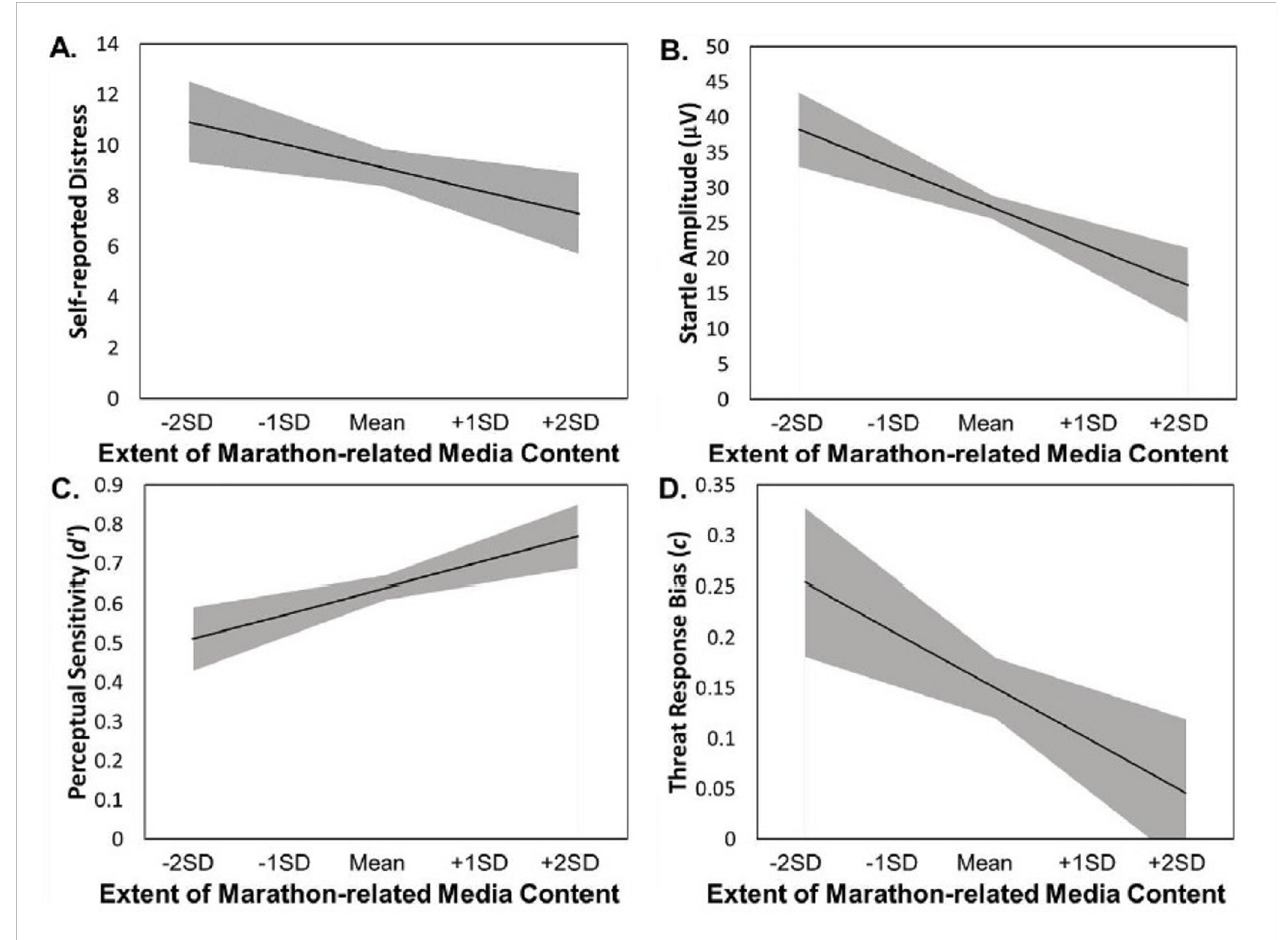
Fig 2. Simple slopes representation of models predicting changes in distress (Panel A), startle reactivity (Panel B), perceptual sensitivity (Panel C), and Threat response bias (Panel D) by changes in the extent of recent marathon-related coverage. Extent of recent marathon-related media coverage was calculated to be time-locked for each participant at each Wave to include only media coverage from the two weeks prior to that participant’s laboratory visit. Model slopes are represented by a black line, with ± 1 standard error of the slope and intercept for each model shown as a gray-shaded area. SD stands for standard deviation. The model for perceptual sensitivity (Panel C) is plotted at the within-person mean for threat response bias, and the model for threat response bias (Panel D) is plotted at the within-person mean for perceptual sensitivity.